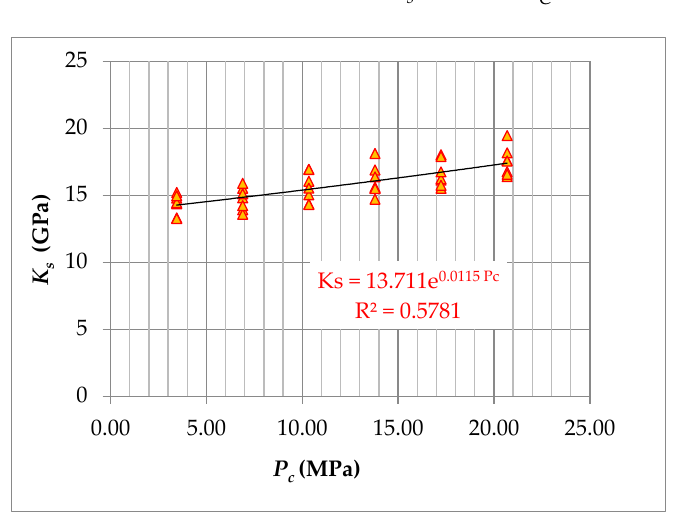
Figure 7. Calculated values of 𝐾 𝑠 as a function of the hydrostatic stress (Method 3).